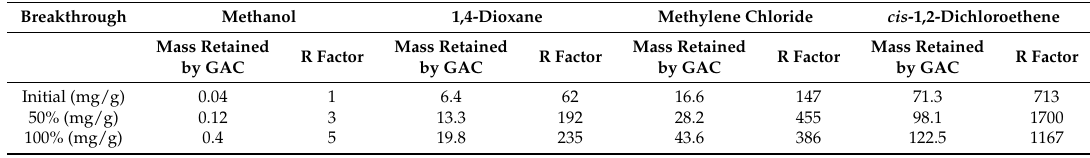
Table 1. Methanol, 1,4-dioxane, methylene chloride, cis -1,2-dichloroethene properties determined from 1D column test with granular activated carbon (GAC).